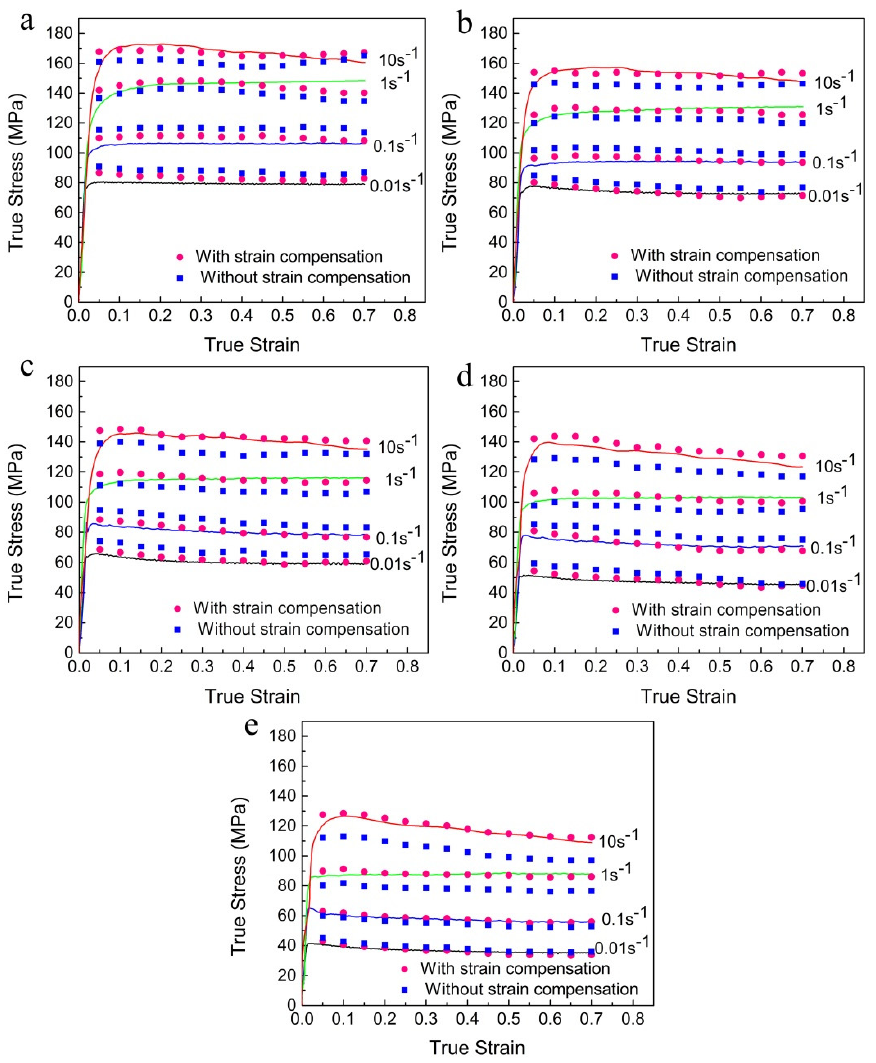
Figure 5. Comparison of the predicted and experimental flow stress curves by two models at deformation temperatures of ( a ) 320 ° C, ( b ) 350 ° C, ( c ) 380 ° C, ( d ) 410 ° C, and ( e ) 440 ° C.